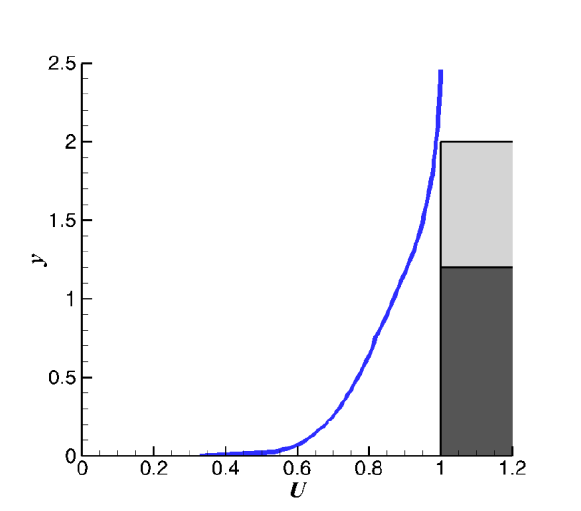
Fig. 3. Mean velocity profile on the model